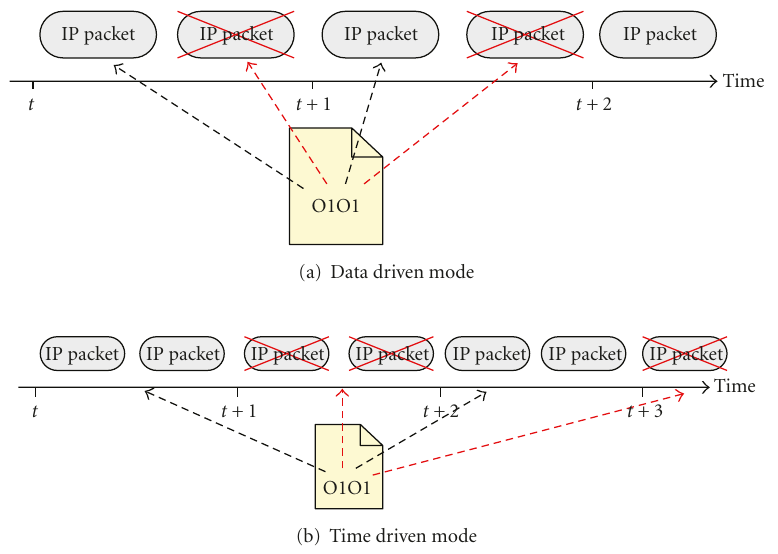
Figure 10: KauNet loss